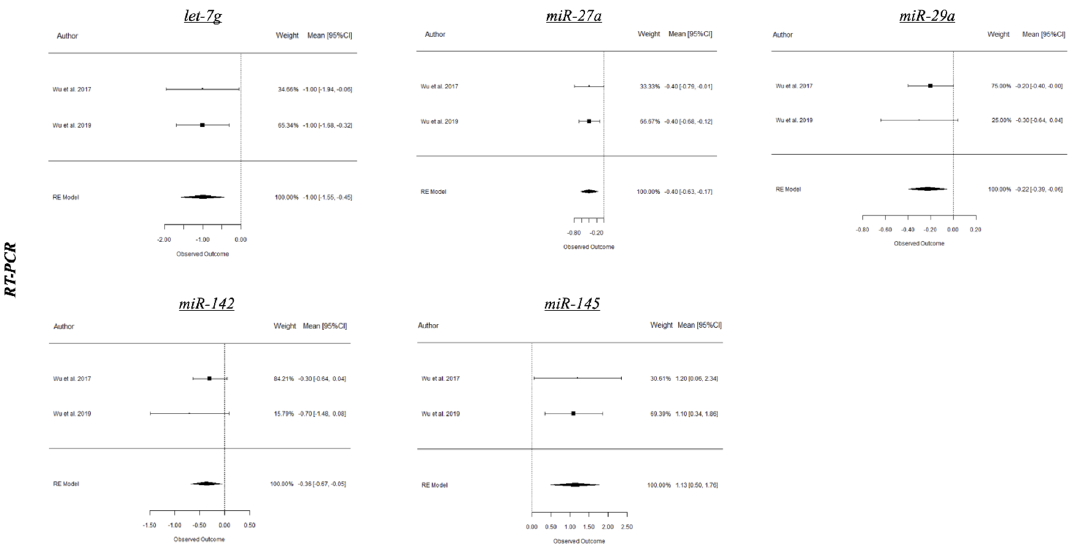
Figure 5. RT-PCR expression of selected miRNAs in peri-implant health and experimental peri-implantitis from animal studies.